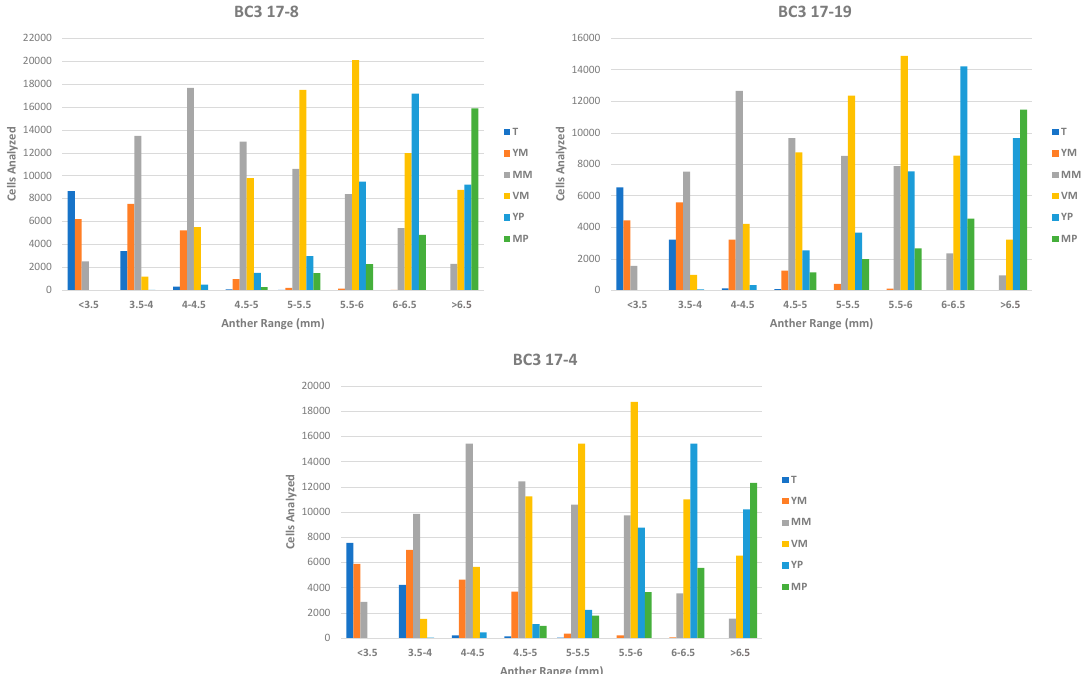
Figure 5. Distribution of the cell types identified by Microscan within each anther range in the three genotypes used for the Phase 2 experiments. The Y axis shows the number of cells classified for each type; the X axis shows the anther range corresponding to each analysis. The color code in the legend indicates the cell type, tetrad (T), young microspores (YM), medium microspores (MM), vacuolated microspores (VM), young pollen (YP) and mature pollen (MP).